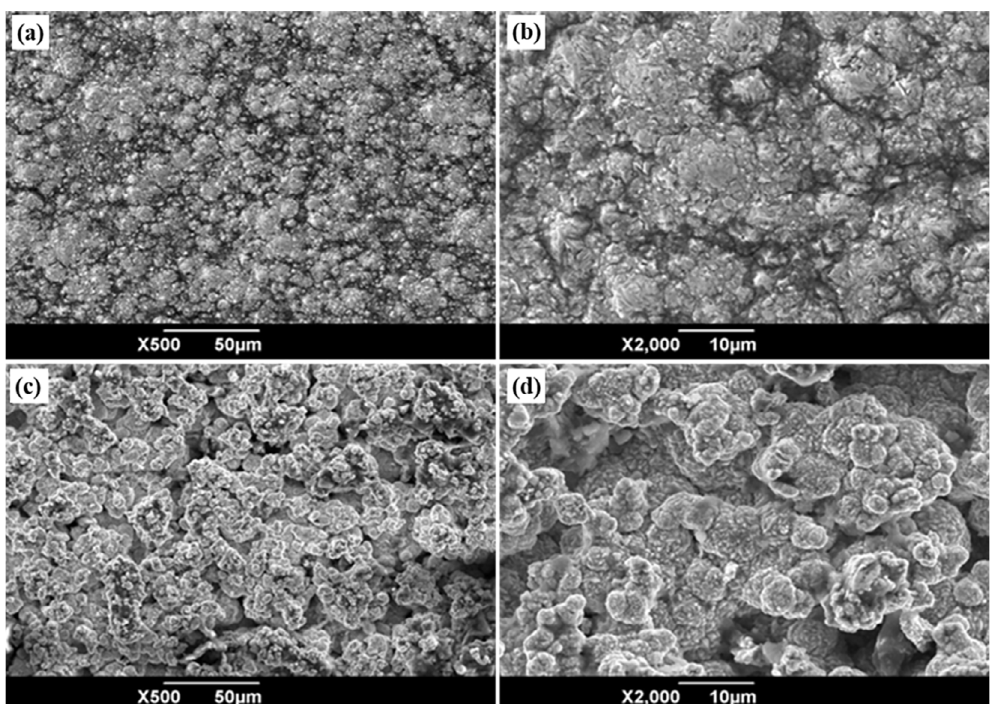
Figure 4. Surface SEM images of coatings: (a) and (b) Ni coating; (c) and (d) Ni-TiC composite